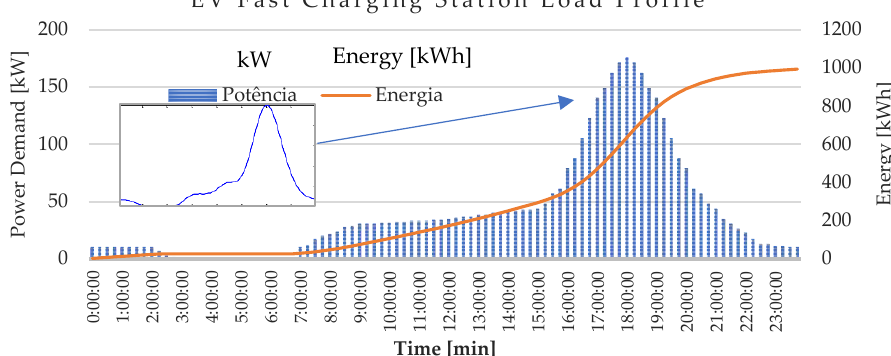
Figure 19. Energy and demand profile: for hypothetical average daily consumption of 1000 kWh/day and typical load curve for fast charging stations [30,31].